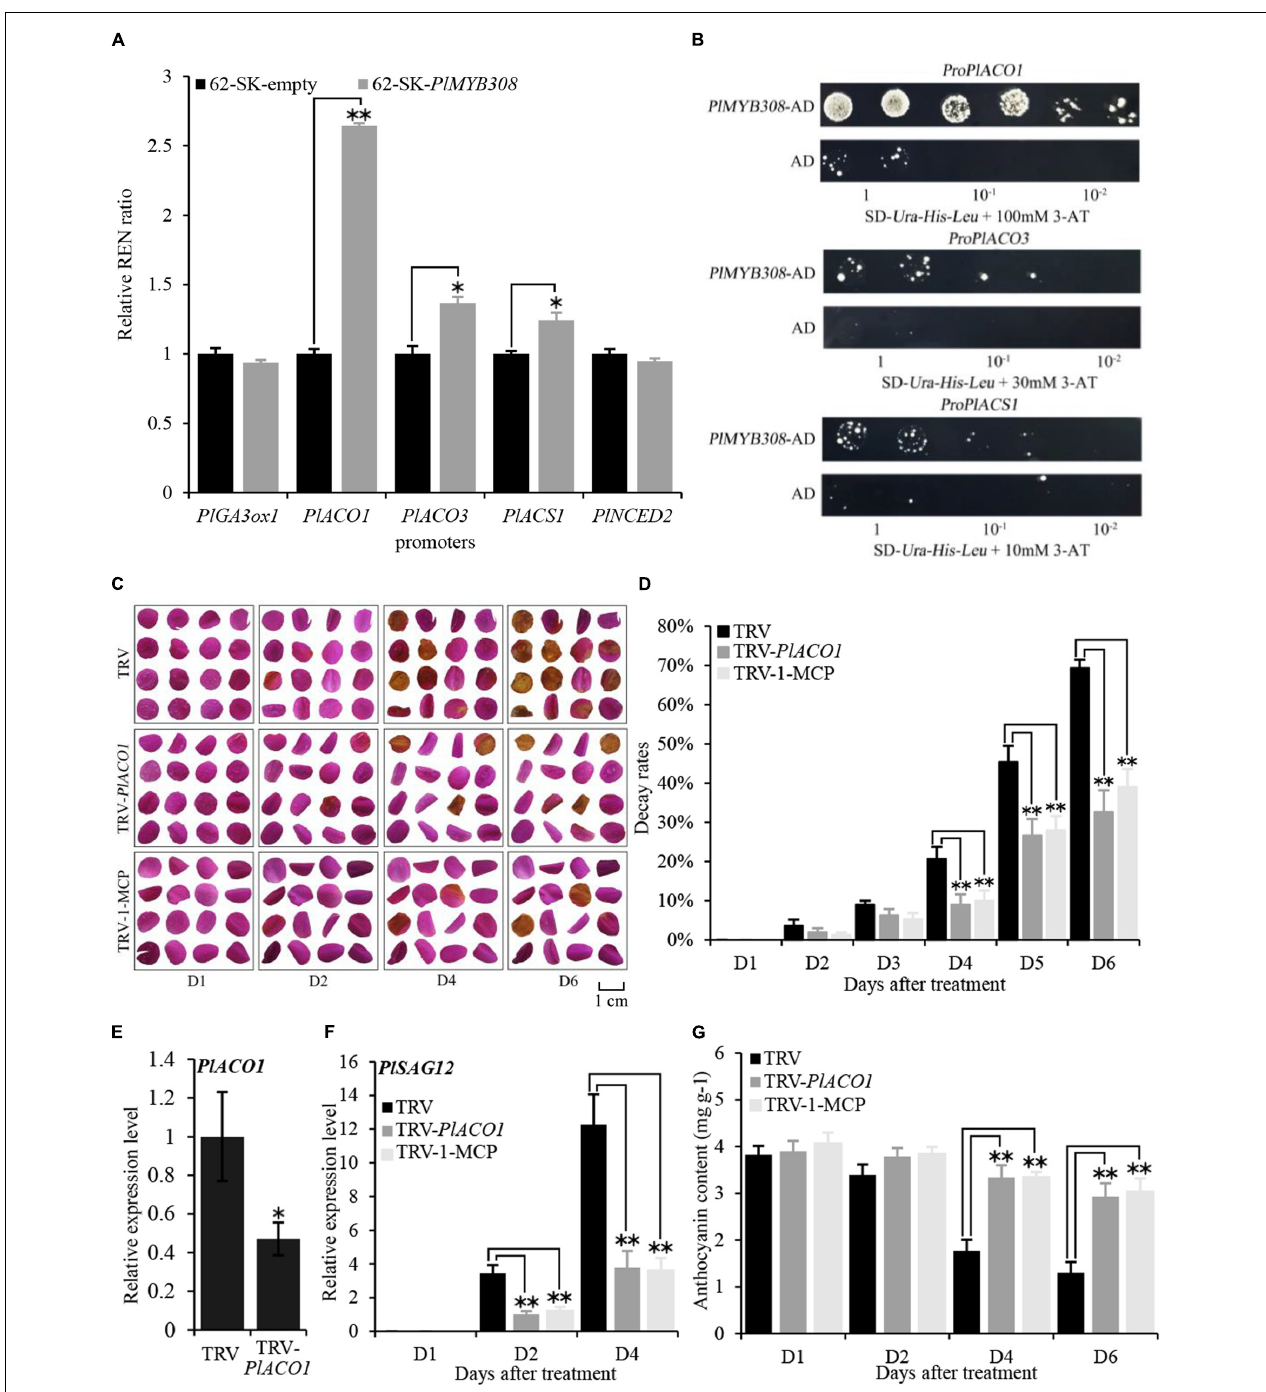
FIGURE 5 | PlMYB308 bound to the promoter of ethylene biosynthetic gene PlACO1 , and PlACO1 silencing delayed the senescence of herbaceous peony petals. (A) PlMYB308 transactivated the promoter of PlACO1 . The ratio of LUC/REN of the empty vector (62-SK) plus promoter was considered as a calibrator (set as 1). The activation is indicated by the ratio of LUC to REN. Data represent the mean ± SD of six independent repeats. (B) The yeast one-hybrid result of PlMYB308 . The transformed yeast was grown on SD-Leu-His-Leu + 3-AT medium. The screening condition was 3-AT 100 mM, 3-AT 30 mM, and 3-AT 10 mM, from the top down. Cells were grown in liquid medium to an optical density at 600 nm of 1.0. The numbers 1,10-1,10-2 indicate the dilutions. (C) The phenotypes of the petal disks were photographed at D1, D2, D4, D6 (TRV: petal disks infiltration with TRV empty vector; TRV- PlACO1 : petal disks infiltration with TRV- PlACO1 ; TRV-1-MCP: petal disks infiltration with TRV empty vector and treated with 1-MCP). (D) Decay rates of the petal disks. Means ± SD for 300 petal disks. (E) Abundances of PlACO1 transcript in empty vector- and TRV- PlACO1 -infected petal disks at D4. PlUB was used as an internal control. (F) Expression levels of PlSAG12 by quantitative real-time PCR in different petal disks. (G) The anthocyanin content at D1, D2, D4, D6. Error bars showed SD of the means of three biological replicates. Asterisks indicated statistically significant differences by Student’s t -test (* P < 0.05, ** P < 0.01).